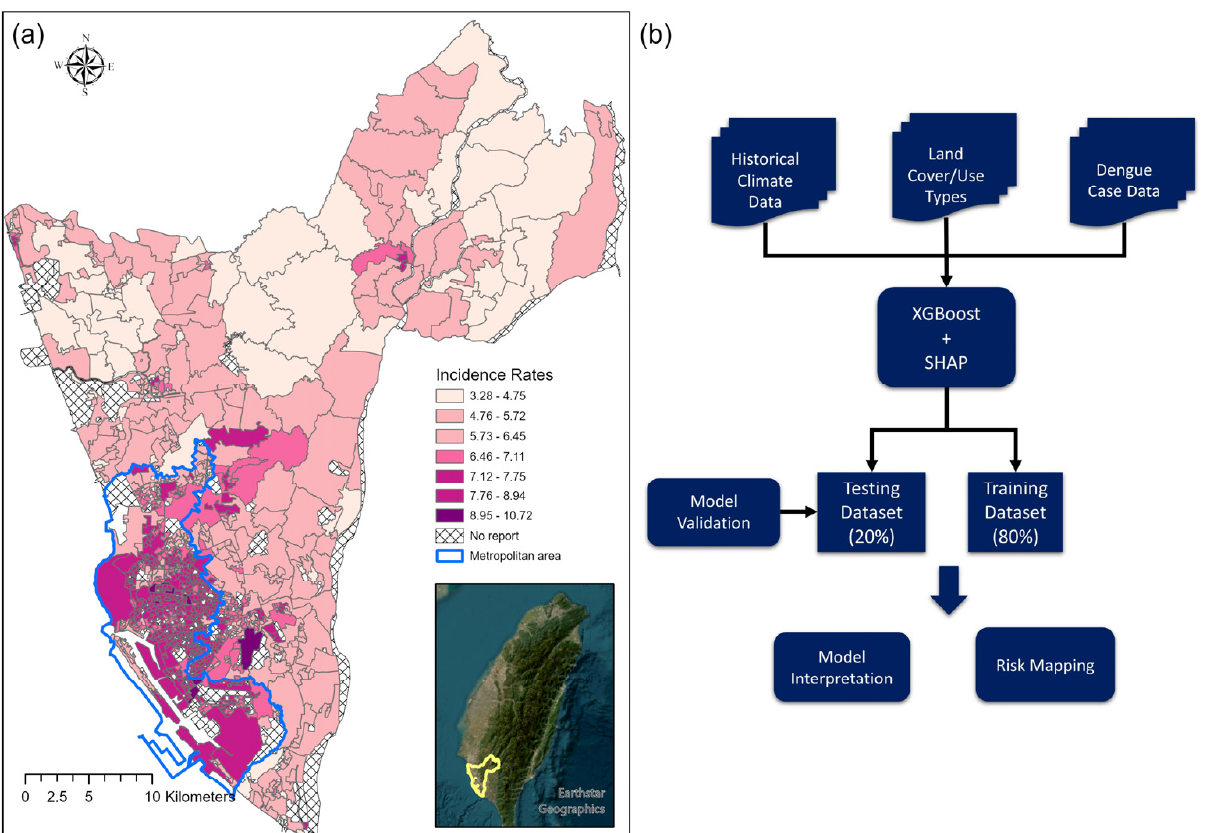
Figure 1. ( a ) Log-transformed dengue incidence rates in second-level dissemination areas in Kaohsiung City, Taiwan. ( b ) The schematic analytical flow of the modeling procedure.